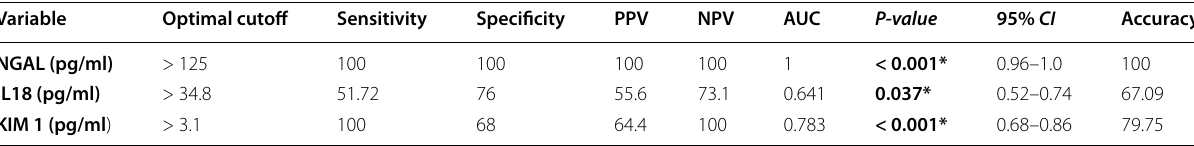
*Significant level at P value <